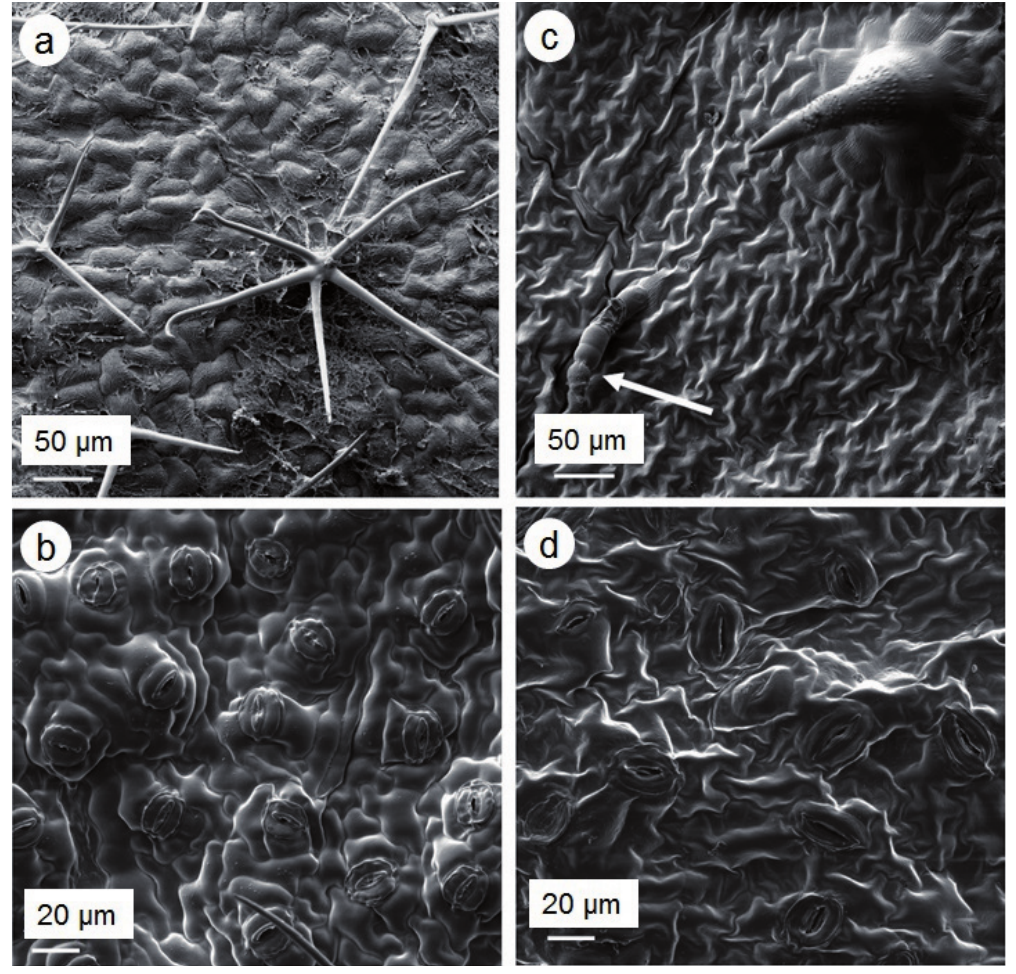
Fig. 6: Scanning electron micrographs of the epidermis of S. hermaphrodita (a, b) and S. perfoliatum (c, d). a: stellate trichomes on upper epidermis. b: lower epidermis with stomata. c: simple trichomes on upper epidermis (arrow indicates that trichomes of S. perfoliatum may have spiky as well as rounded tops). d: lower epidermis with